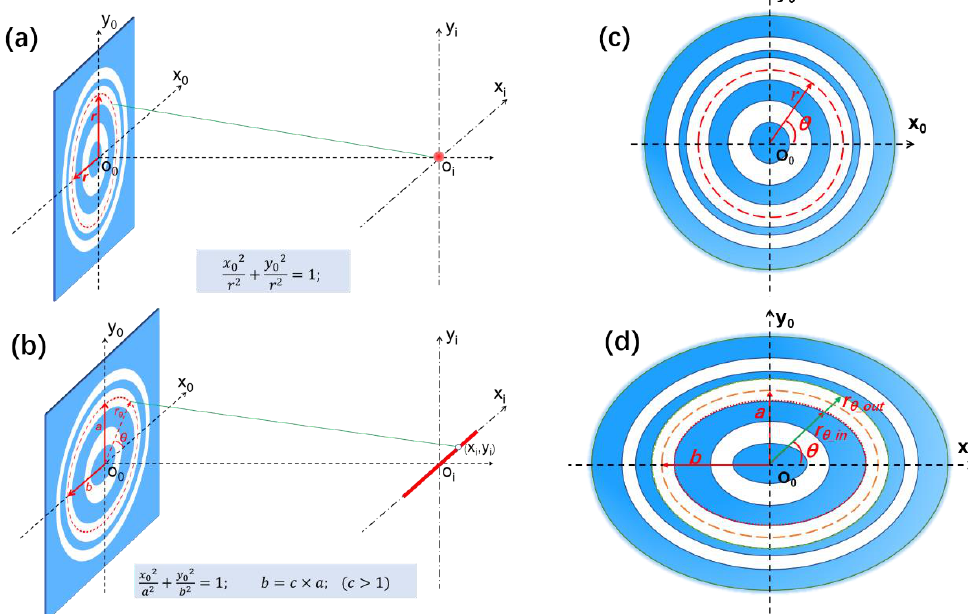
Figure 1. Schematic comparison between the circular and elliptical configuration of planar metalens. ( a ) shaping an isotropic focal spot by a circular planar metalens; ( b ) shaping a transverse optical needle in the focal plane by an elliptical planer metalens, where a and b are the semi-minor and semi-major axis length; ( c ) parameters of a planar metalens with circular configuration, where r is the radius of each transparent belt, and θ is the azimuthal angle; ( d ) parameters of a planar metalens with elliptical configuration, where the r θ _in and r θ _out indicate the inner and outer radial length of a transparent elliptical belt at the angle θ